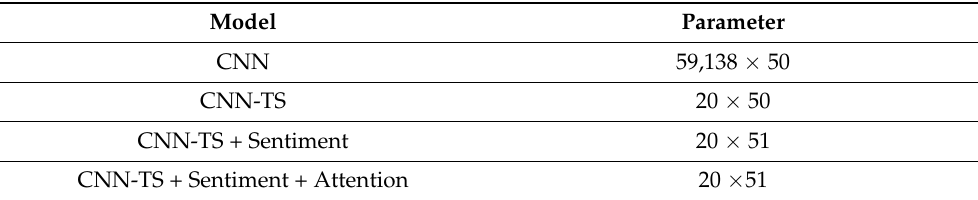
Table 5. Comparison of parameters of the rumor detection